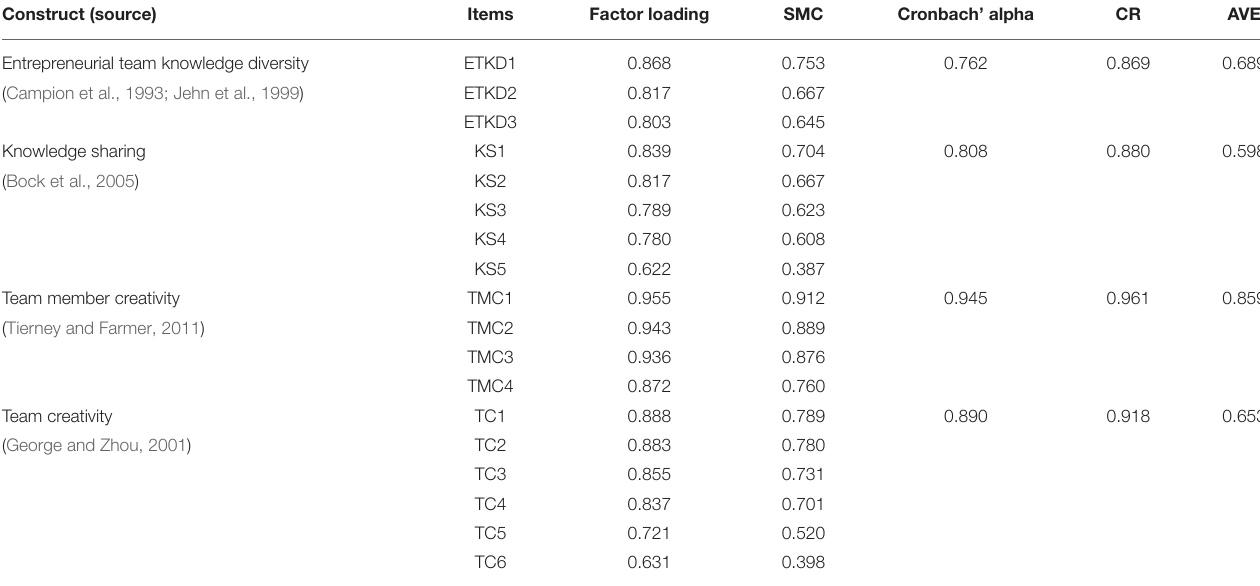
TABLE 2 | Overall reliability of the constructs and factor loadings of